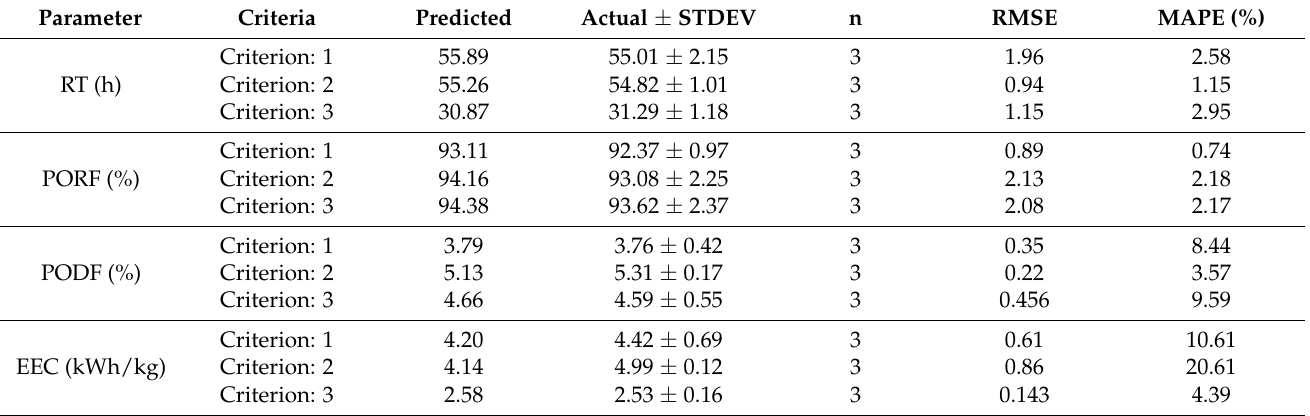
Table 6. The results of the validation experiments compared with the predicted values under the optimization criteria. STDEV, n, RMSE, and MAPE represent the standard deviation, the number of measurements, root mean square error, and mean absolute percentage error,